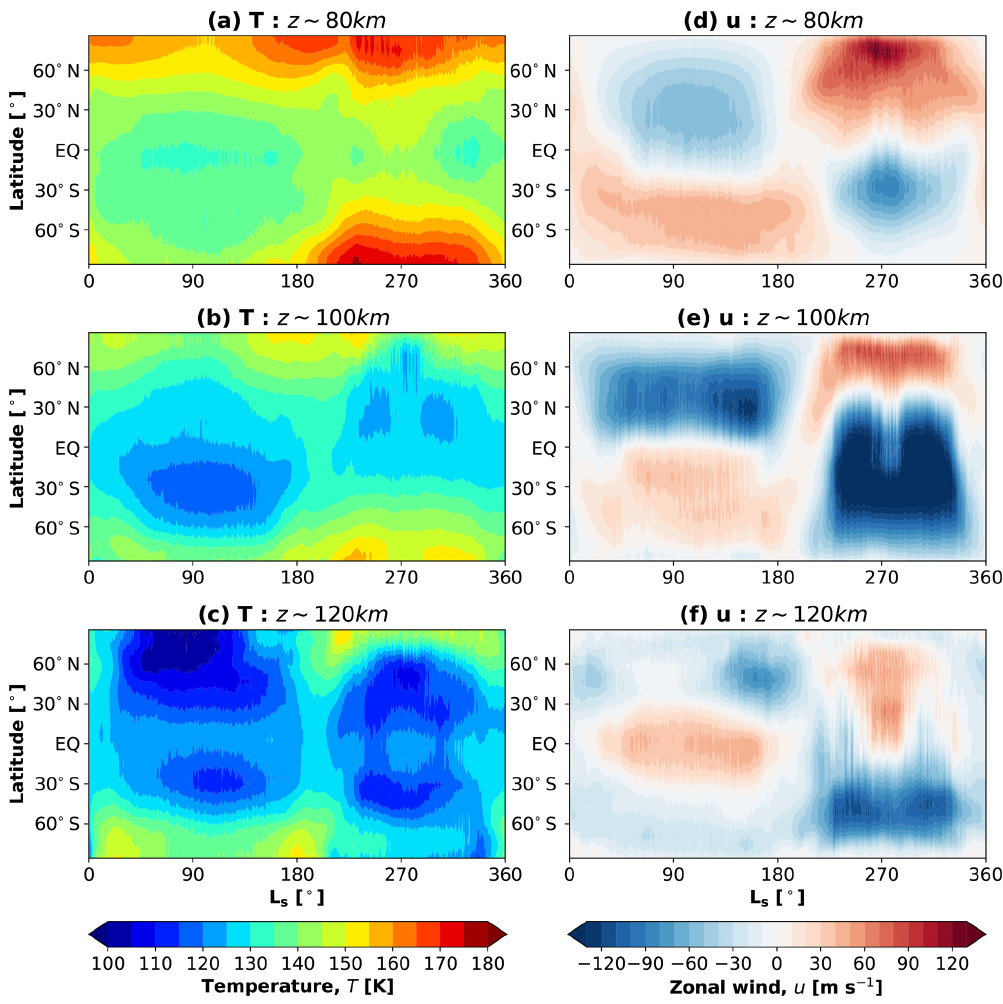
Figure 4. Seasonal variations of mean (i.e., daily and zonally averaged) atmospheric fields. (a) Temperature ( T ) at 80km, (b) T at 100km, (c) T at 120km, (d) zonal wind ( u ) at 80km, (e) u at 100km, and (f) u at 120km. Temperature is in K and the zonal wind is in ms − 1 . Red/blue shadings for the wind represent eastward/westward winds. A Martian year has about 669 sols, which is plotted in terms of solar longitude L s (in degrees) from L s = 0 to 360 ◦ . L s = 0 ◦ marks the vernal equinox in the Northern Hemisphere. L s = 90 ◦ and L s = 270 ◦ are aphelion and perihelion seasons,